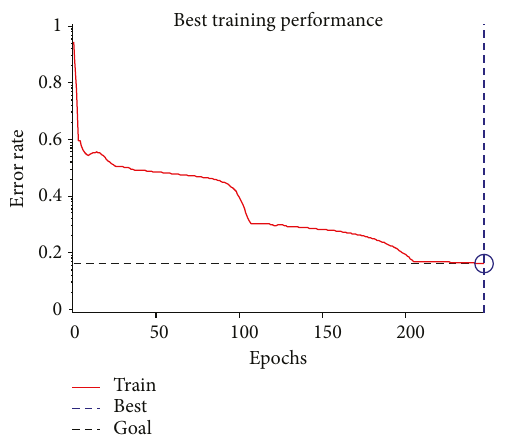
Figure 11: Network training of concrete engineering.